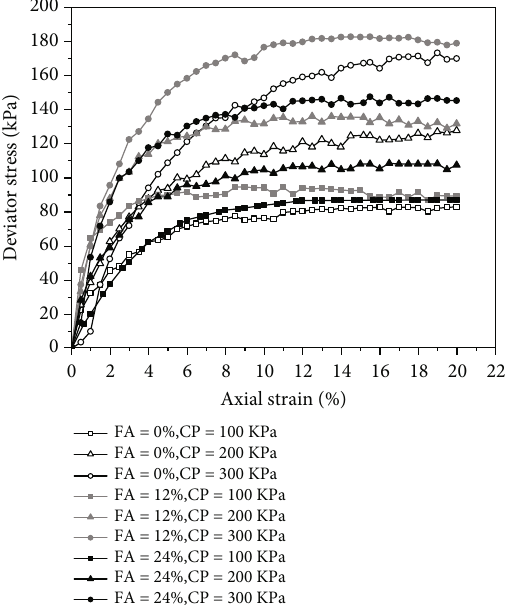
Figure 7: Stress-strain curves ( FT = 0 , L = 0 % ).